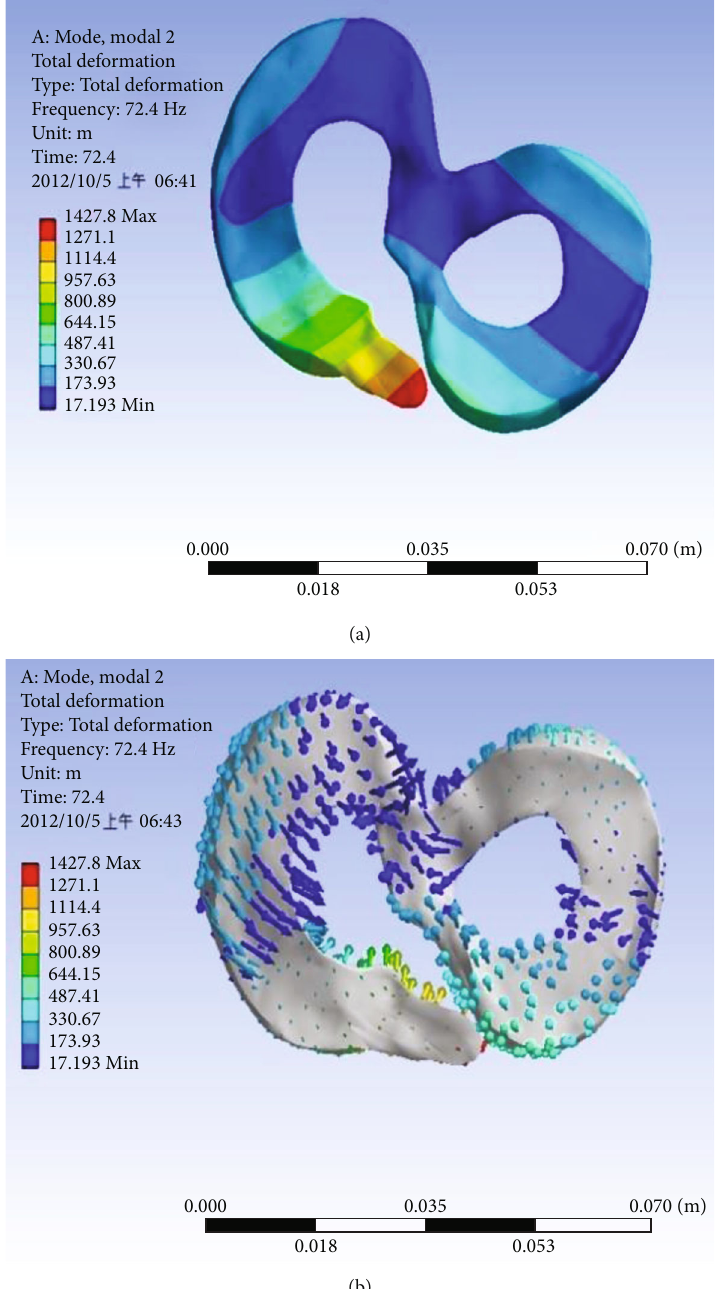
Figure 5: First mode shape of meniscus model at 72.4Hz (bending vibration via thickness direction). (a) First mode shape. (b) Vector plot of fi rst mode